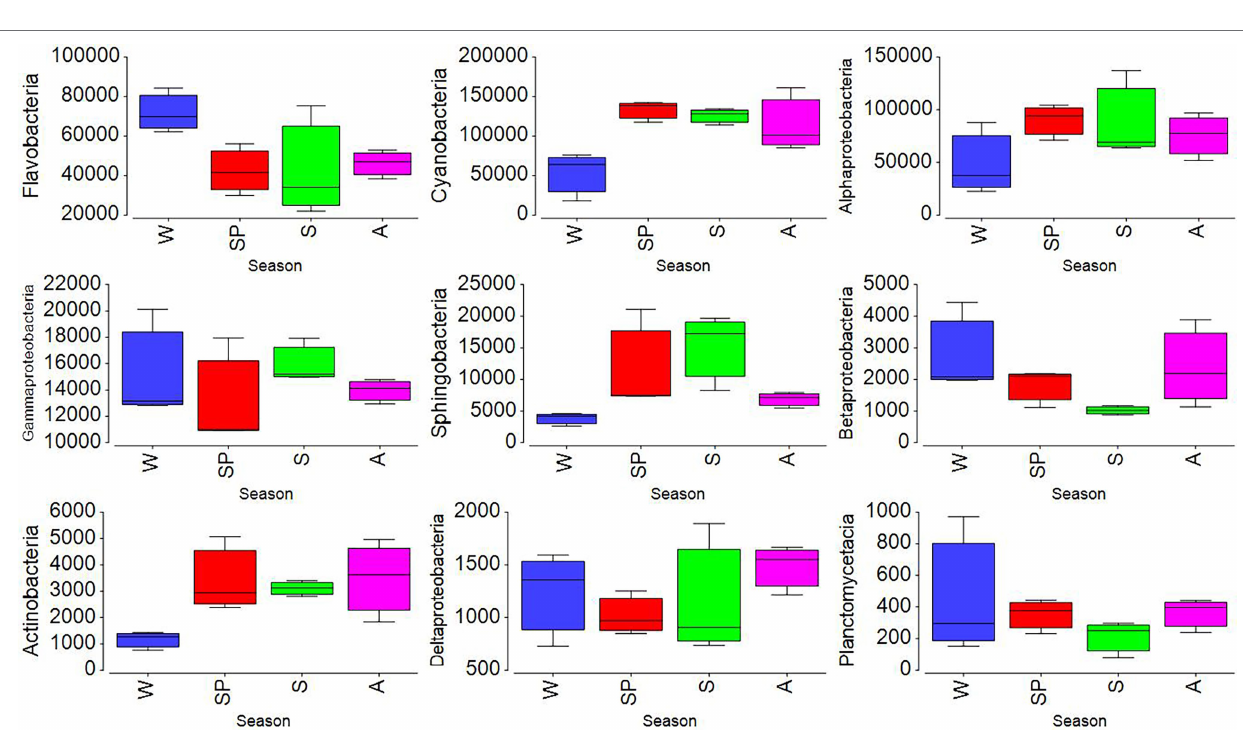
FIGURE 4 | Seasonal variations of selected dominant taxonomic class (cells mL − 1 ) obtained by multiplying their relative abundances by total bacteria abundance obtained from flow cytometry analysis. Here, symbols represent W (winter), SP (spring), S (summer), and A